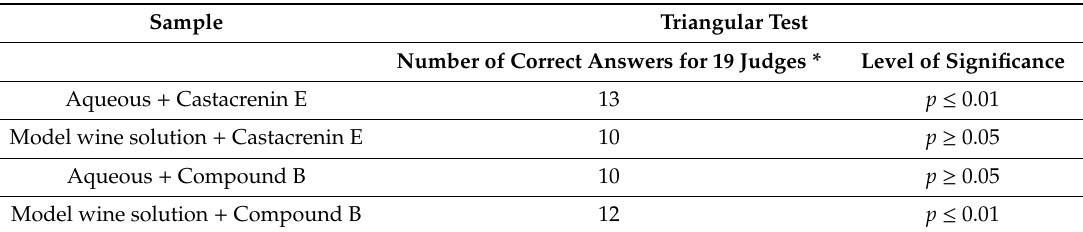
Table A1. Results of triangular test.